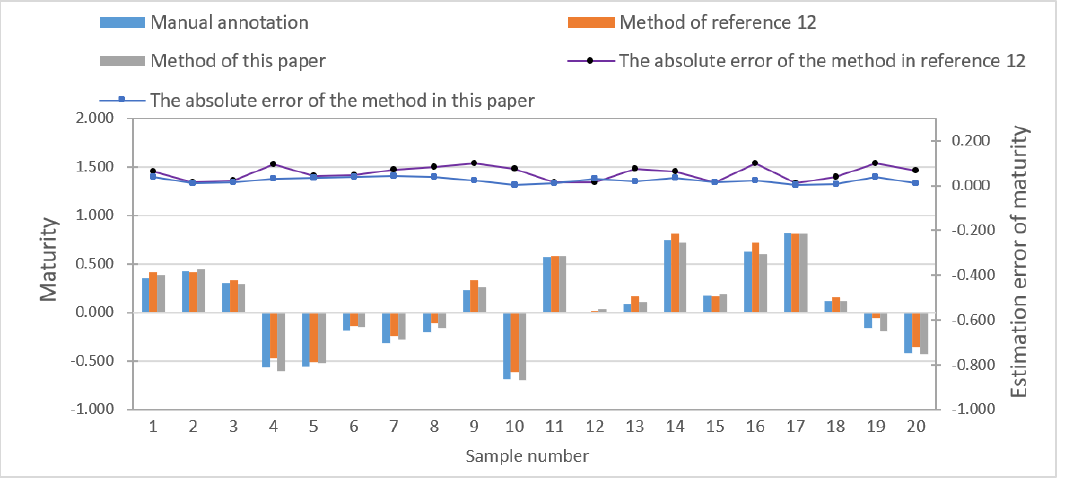
Figure 15. The comparison of evaluation results of cotton fiber quality between method in this paper and method in Reference